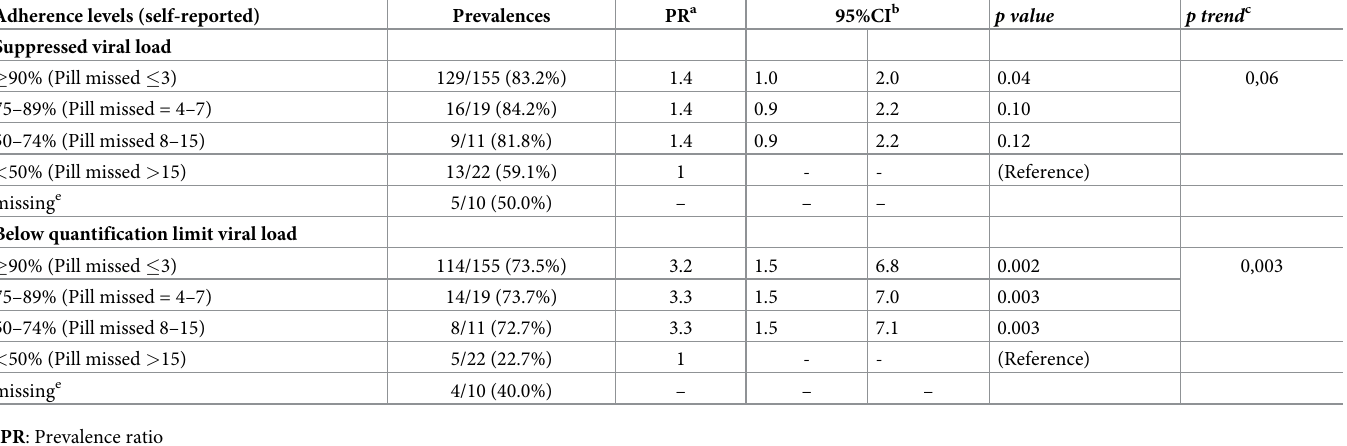
Table 2. Prevalence ratio of below quantification limit and suppressed viral load according to self-reported adherence levels among FSWs participating in the TasP demonstration study in Benin. Adherence levels